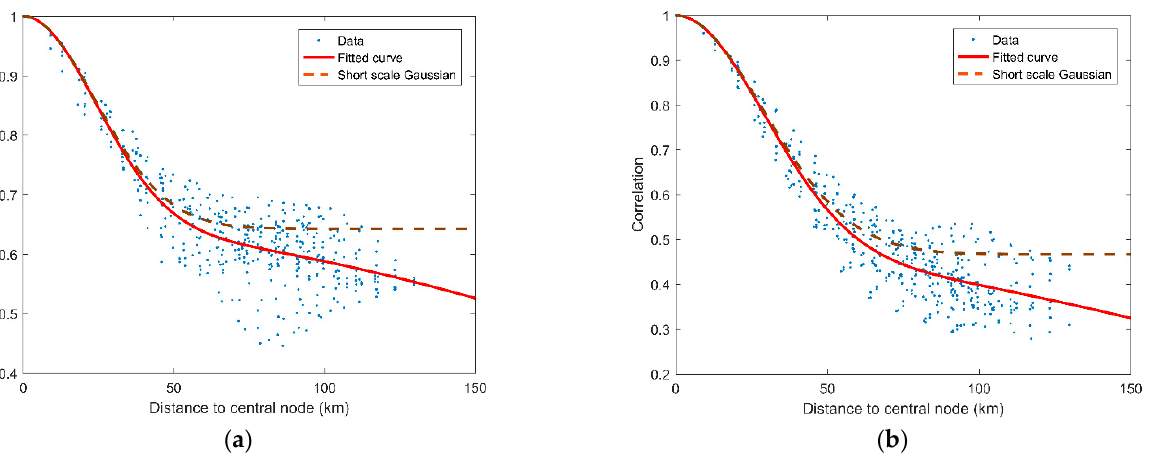
Figure 2. Correlation data sets for SST at two locations of the ‘central’ node, n 0: ( a ) 10.7° N, 70.3° E and ( b ) 7.3° N and 76.2° E. Blue dots represent correlation coefficients of SST fluctuations between the central node and surrounding nodes, 𝑛𝑖 . The solid red line represents the fitted two-scale correlation function according to Equation (2). The dashed line shows a superimposed Gaussian curve corresponding to the short correlation scale so it can be visually compared with the two-scale correlation function.